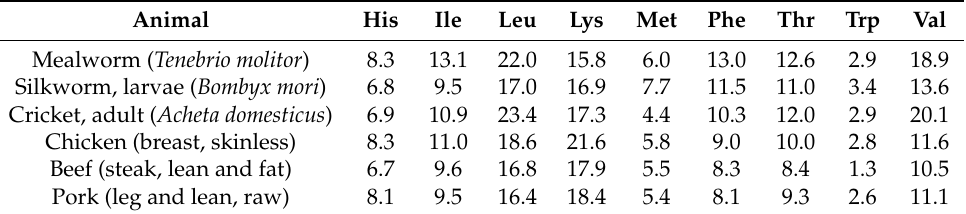
Table 1. Essential amino acid content of edible insects (based on dry matter, g / kg). Animal His Ile Leu Lys Met Phe Thr Trp Val Mealworm ( Tenebrio molitor ) 8.3 13.1 22.0 15.8 6.0 13.0 12.6 2.9 18.9 Silkworm, larvae ( Bombyx mori ) 6.8 9.5 17.0 16.9 7.7 11.5 11.0 3.4 13.6 Cricket, adult ( Acheta domesticus ) 6.9 10.9 23.4 17.3 20.1 Chicken (breast, skinless) 8.3 11.0 18.6 21.6 5.8 9.0 10.0 2.8 11.6 Beef (steak, lean and fat) 6.7 9.6 16.8 17.9 5.5 8.3 8.4 10.5 Pork (leg and lean, raw) 8.1 16.4 11.1 (Source: Köhler et al. [22]; Wu et al. [23]; USDA database